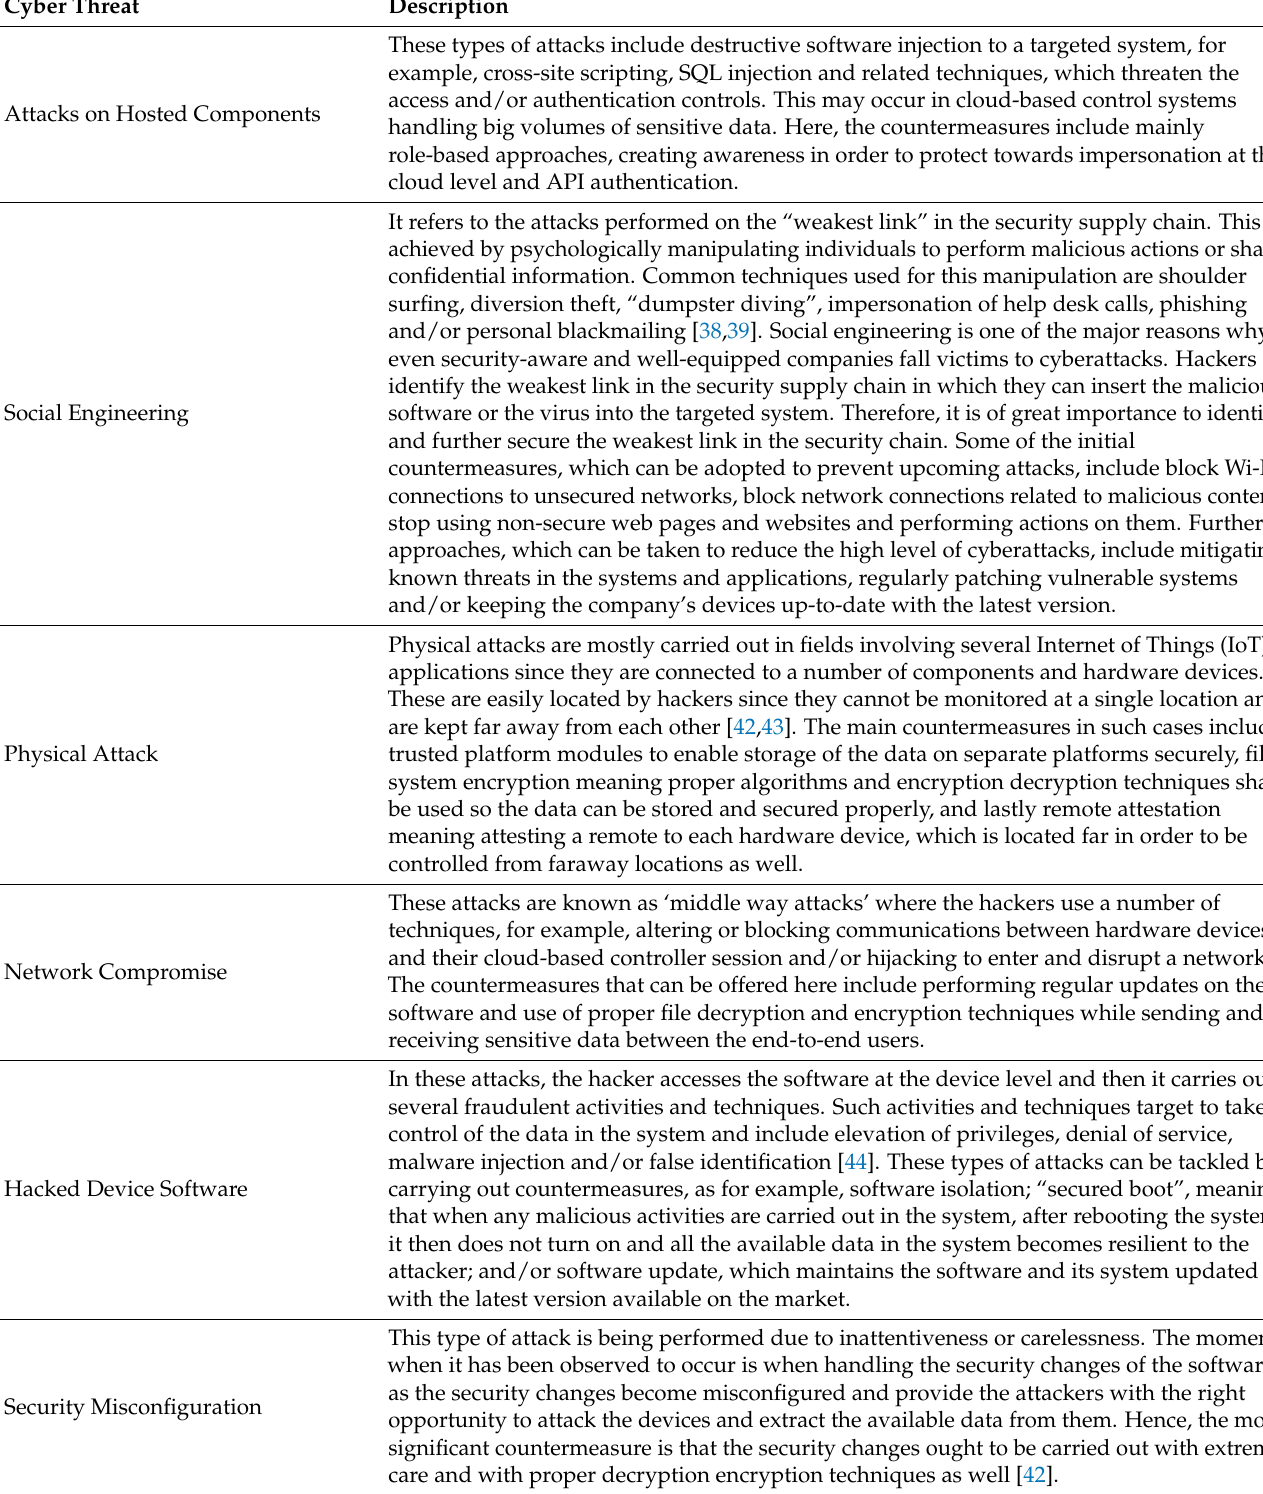
Table 1. Cyber Threats in the